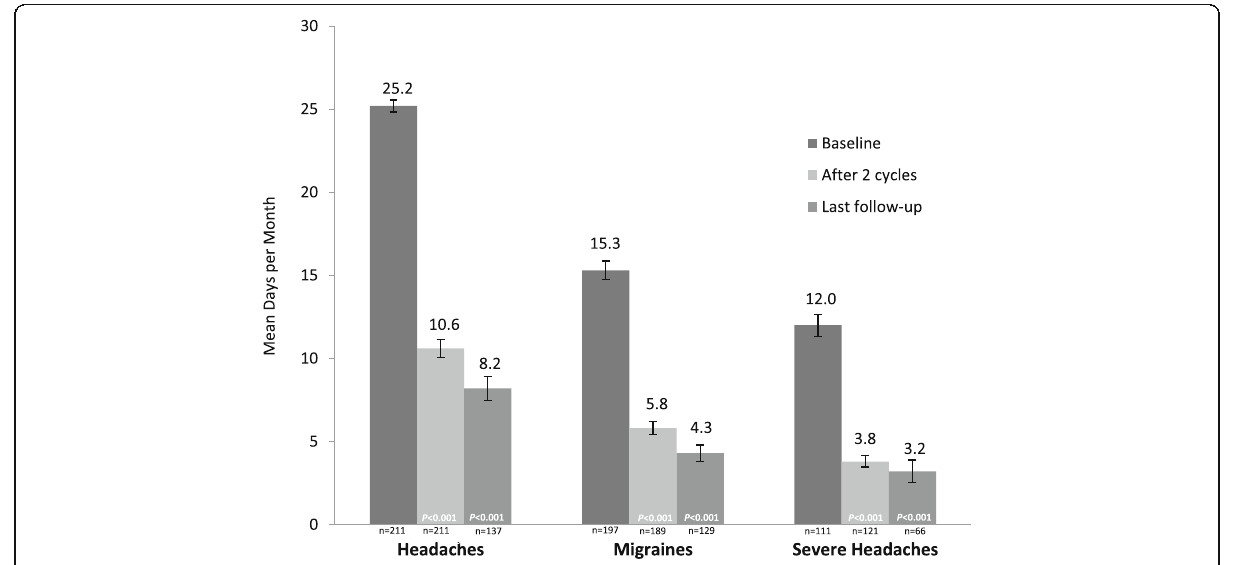
Fig. 2 Frequency of headache, migraine, and severe headache days. The n ’ s represent patients with available data at each time point. P -values indicate significant decrease from baseline, one-sided t